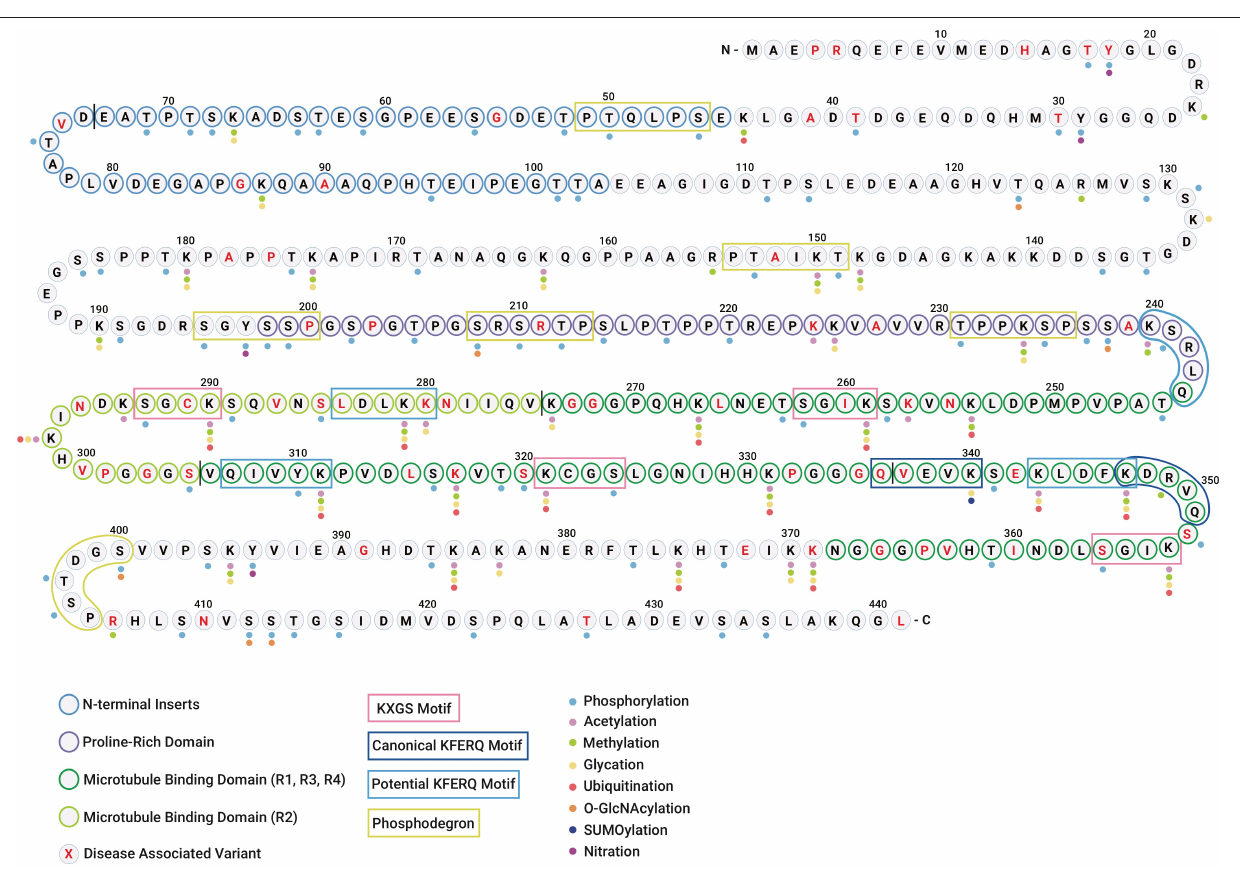
FIGURE 3 | Tau undergoes diverse post-translational modifications that often compete for the same amino acid residues. Diagram showing the polypeptide chain of the longest tau isoform 2N4R tau along with individual amino acid residues highlighting different regions/domains. The N-terminal inserts are represented with blue residue borders, proline-rich domain is represented with purple residue borders, microtubule-binding domains are represented with green residue borders (R1, R3, R4 in dark green, and R2 in light green), and disease-associated amino acid variants are highlighted in red text. The vertical black line between residues is shown for distinction between two N-terminal inserts and four microtubule-binding repeats. The colored dots represent the PTMs identified in tau (WT and mutant) in vitro and in vivo . The color code for PTMs is as follows: phosphorylation (light blue), acetylation (pink), methylation (green), glycation (yellow), ubiquitination (red), O-GlcNAcylation (orange), SUMOylation (dark blue), and nitration (purple). N-glycosylation is omitted as no specific sites have been identified. The KXGS microtubule-binding motifs are shown in pink boxes. The canonical and potential KFERQ motifs are represented with dark blue and light blue boxes, respectively. The phosphodegron motifs are highlighted with green